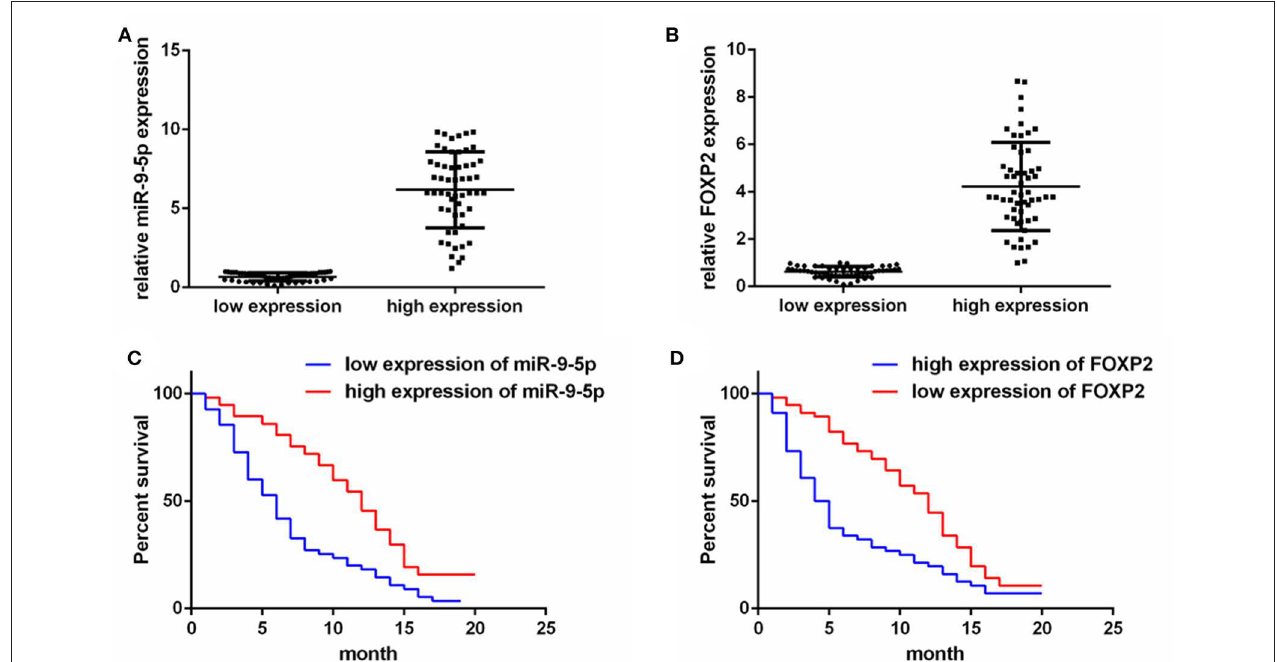
FIGURE 1 | The expression of miR-9-5p and FOXP2 in glioblastoma and patients’ survival. (A) Cases are divided into two groups according to the expression of miR-9-5p in GBM. (B) Cases are divided into two groups according to the expression of FOXP2 in GBM. (C) Kaplan-Meir survival curve analysis reveals that lower miR-9-5p predicts poorer survival (110 GBM patients). (D) Kaplan-Meir survival curve analysis reveals that higher FOXP2 predicts poorer survival (110 GBM patients).